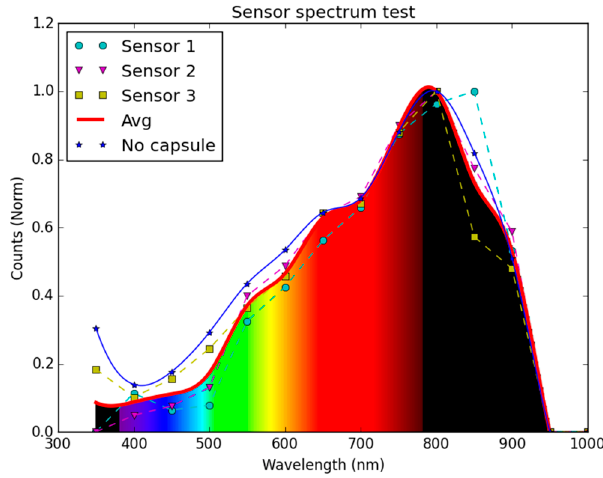
Figure 9. Spectrum response of the TSL230RD with the Synolite capsule and comparison to the response without capsule.